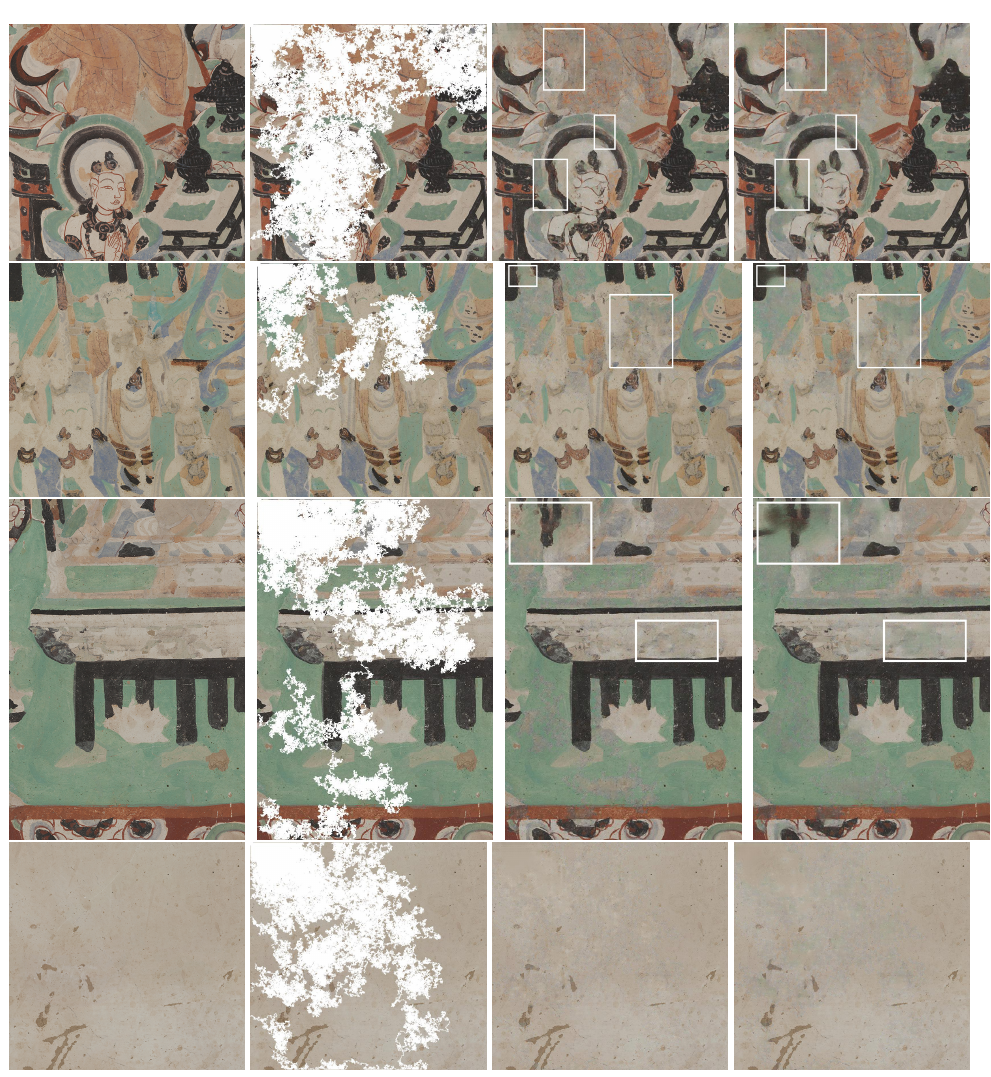
Figure 11. The columns represent in order, from left to right: original image, deteriorated image with RW mask, inpainted image with our approach, inpainted image with the approach of [17]. In the highlighted regions of interest, our approach outputs more color coherent and sharper